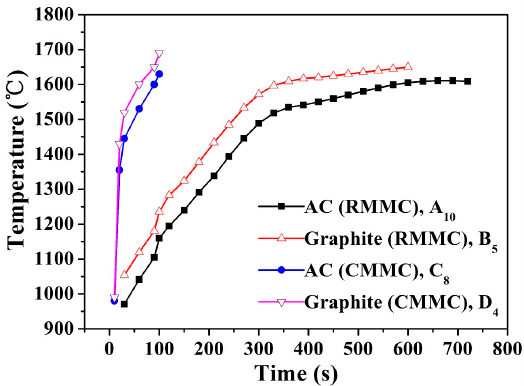
Figure 4. Heating curves of AC/graphite Microwave susceptor in RMMC and CMMC reactors.